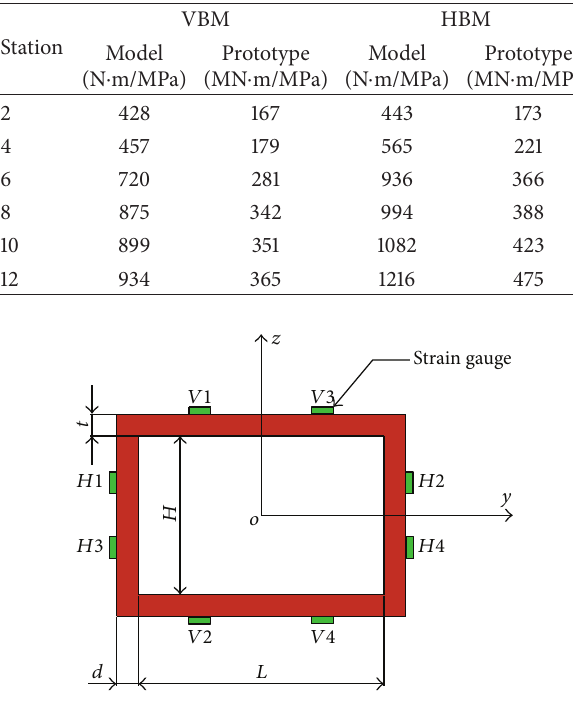
Figure 6: Sketch of the model hull global vibration